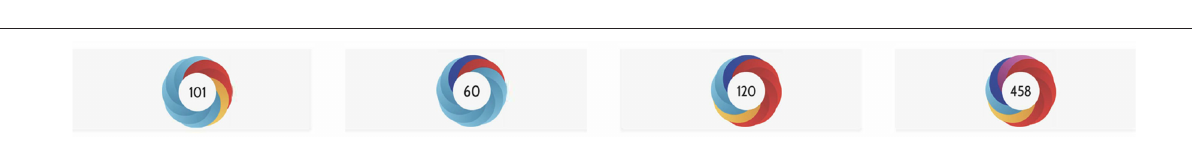
FIGURE 8 | Altmetric badges for various publications. The preponderance of light blue in the two left badges suggests that the corresponding publications drew most of their alternative impact from tweets. The preponderance of red in the two right badges suggests that the corresponding publications drew most of their alternative impact from press coverage. Altmetric badges captured on August 11, 2019 and displayed here with permission from